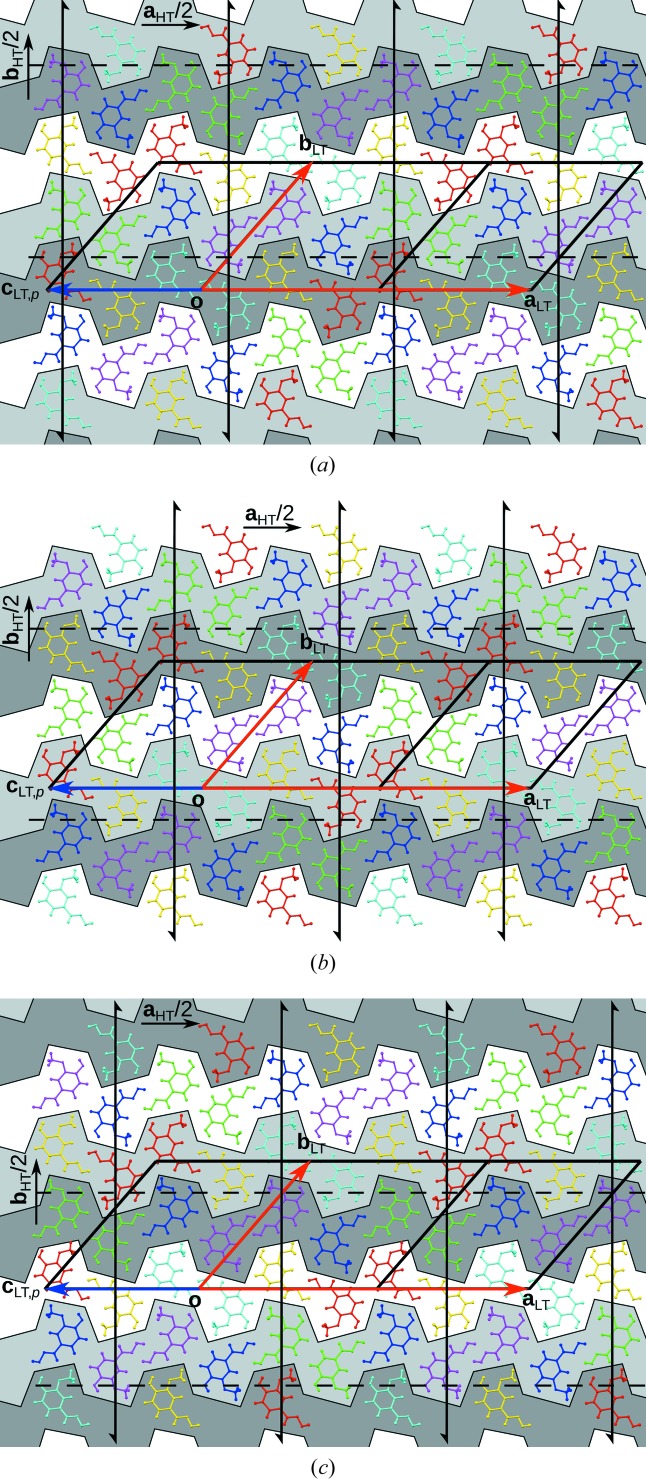
Source (dark grey) and target (light grey) molecules of partial screw rotations and glide planes with intrinsic translation (6n + 1)b
HT/2 and (6n + 1)a
HT/2, respectively. Molecule colours are as in Fig. 3 ▸.